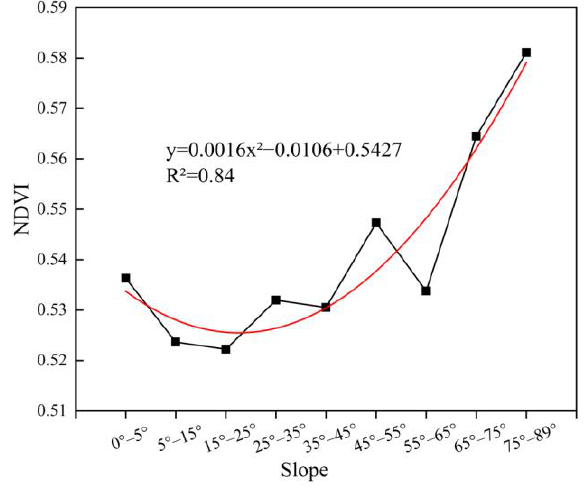
Figure 17. The relationship of the slope and